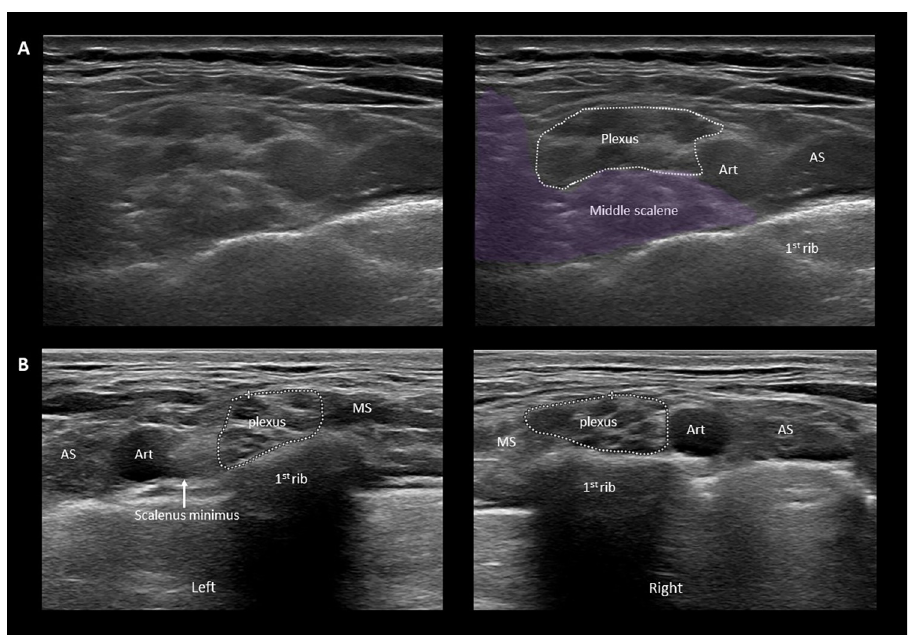
Fig 3. Muscle anomalies in the supraclavicular region. A . Axial images of the supraclavicular fossa showing the anomalous medial insertion of the middle scalene muscle on the 1 st rib in a patient with neurogenic + arterial TOS. Note how the muscle elevates the brachial plexus and has a space-occupying effect. Compare to image A of Fig 2. Further cephalad, a ‘wedge-sickle sign’ is also present (not shown). B . Axial images of the supraclavicular fossa showing an accessory scalenus minimus muscle in a patient with neurogenic + arterial (supra- + costoclavicular) TOS. Note that on the left side, a supernumerary muscle is present between the subclavian artery and the brachial plexus, which has a space-occupying effect. On the right side, the brachial plexus is located immediately adjacent to the artery. Note also the elevated position of the 1 st rib. MS: middle scalene muscle; AS: anterior scalene muscle; Art: subclavian